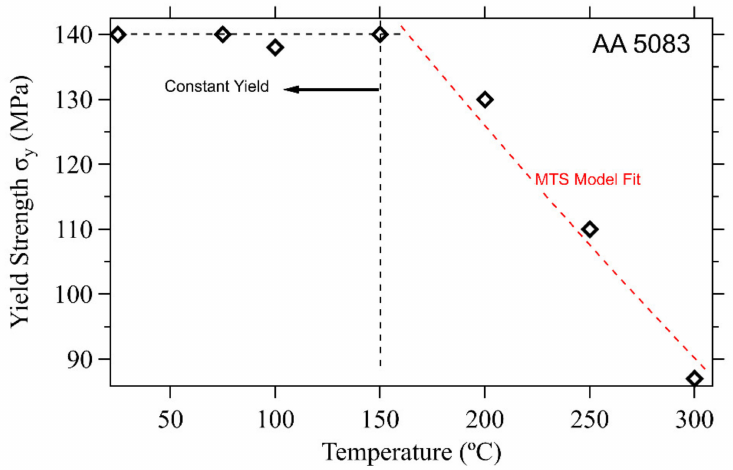
Figure 10. Yield strength MTS model prediction versus temperature (150–300 ◦ C). The elastic modulus model prediction (Equation (11)) versus temperature is plotted in Figure 11. Good agreement with the experimental data was obtained as shown in Figure 11.